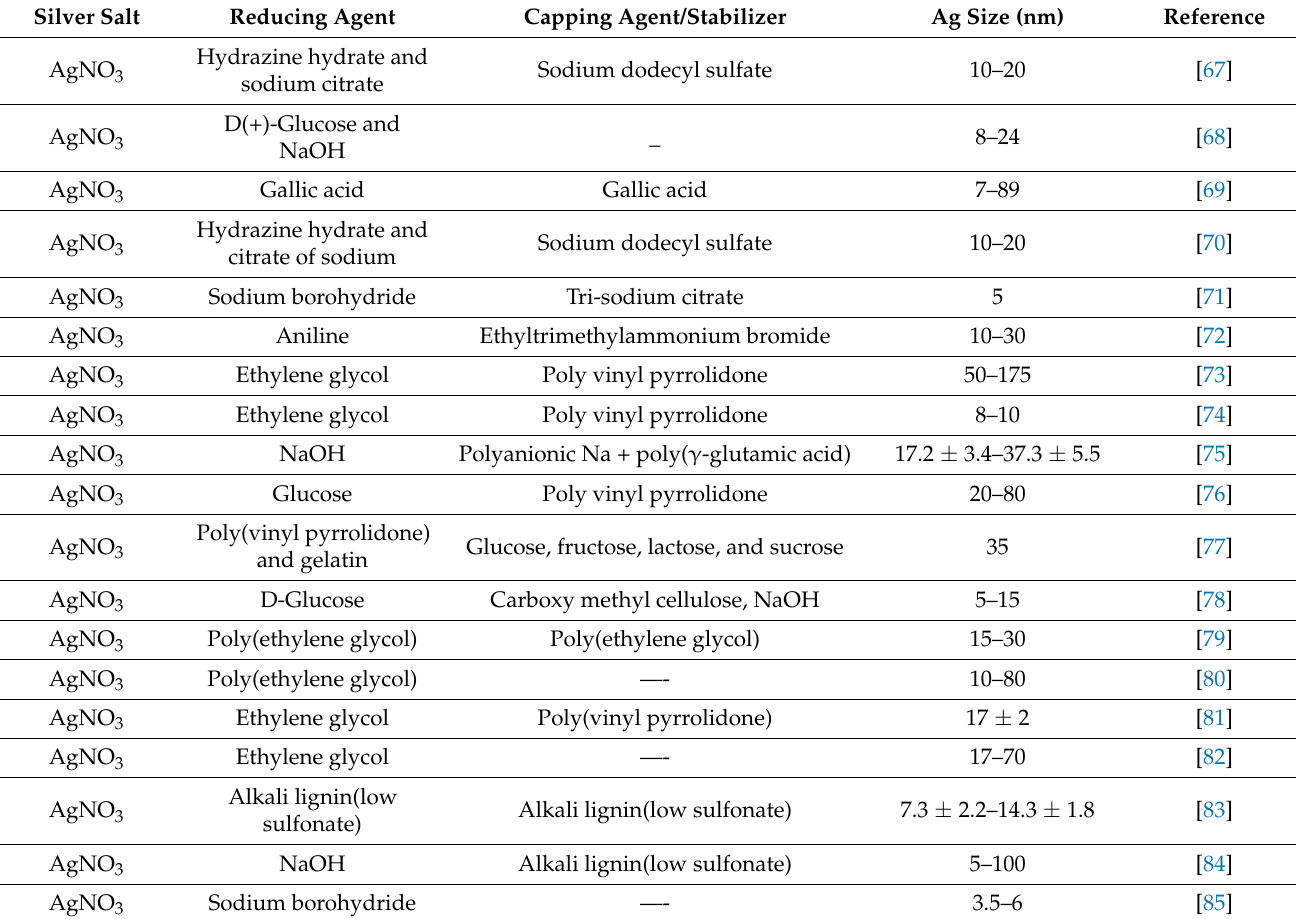
Table 5. Synthesis of AgNPs using chemical